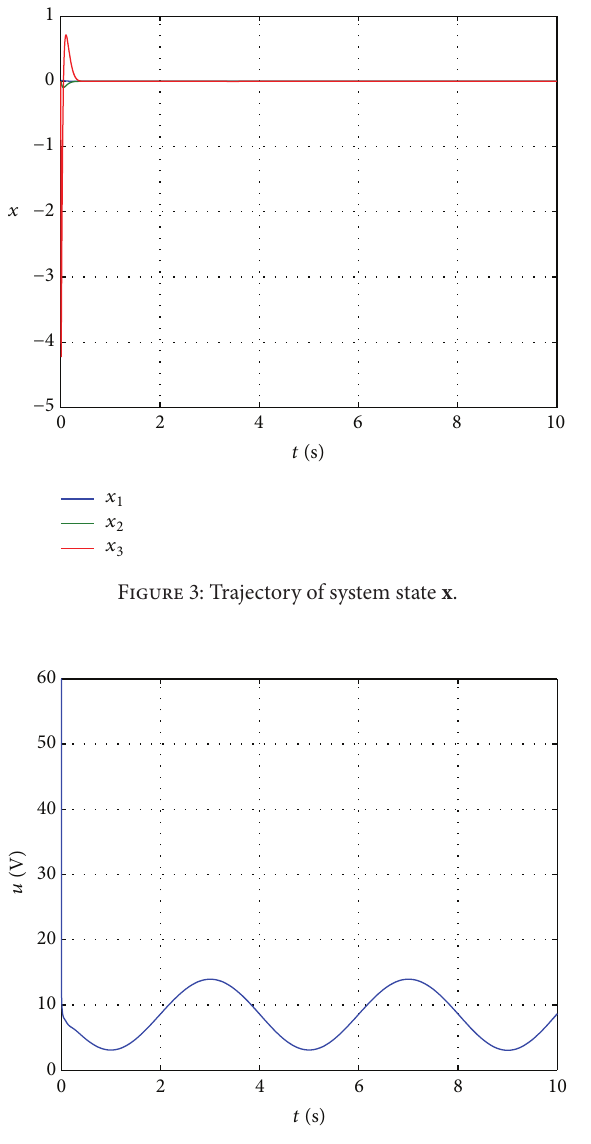
Figure 4: Control input 𝑢 .